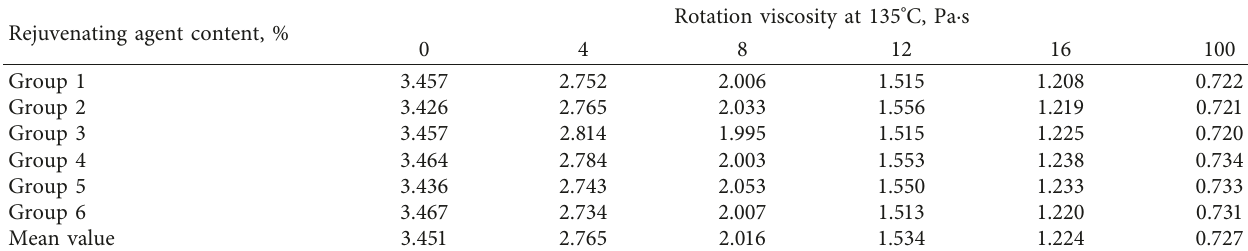
Table 6: Test data of rotation viscosity at 135 ° C of regenerated asphalt with regenerant. Rejuvenating agent content,